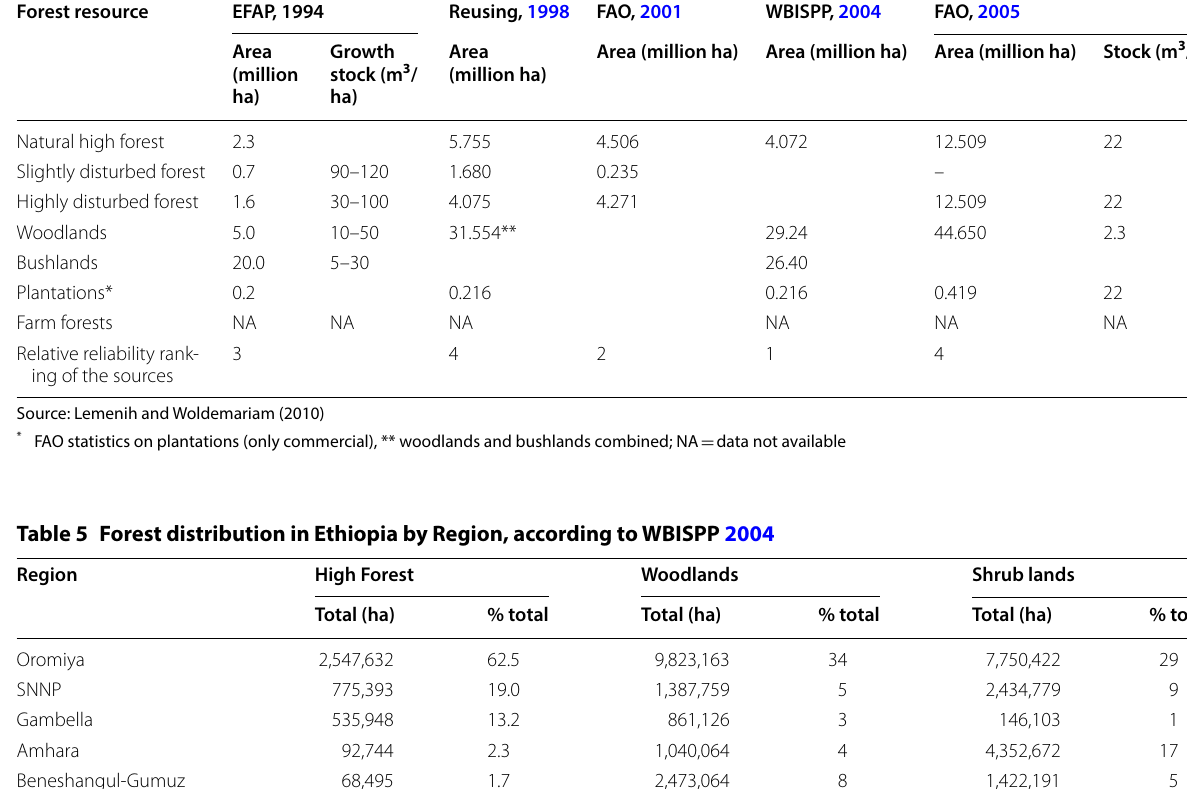
Table 4 Forest resource statistics in Ethiopia reported by different sources Forest resource